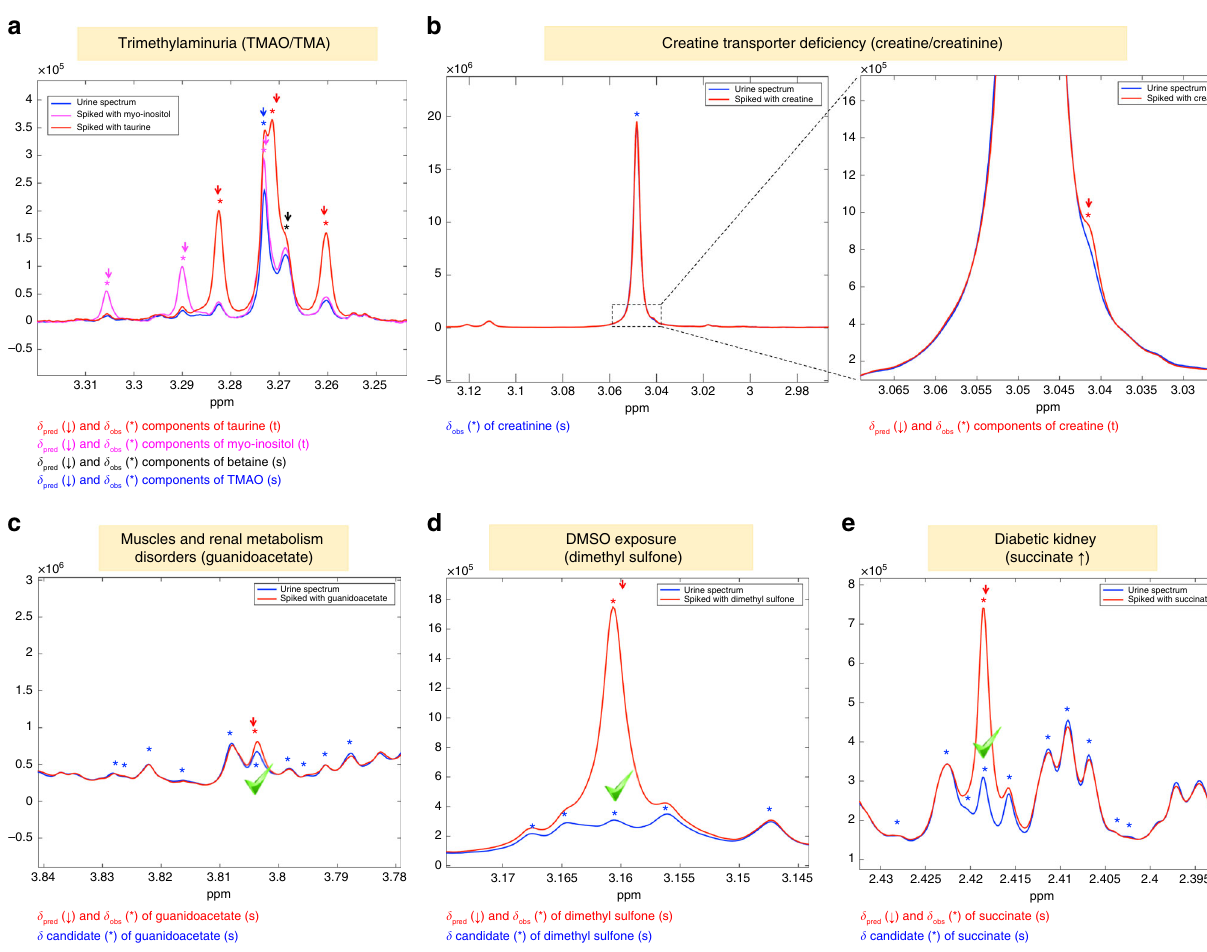
Fig. 7 Examples of dif fi cult metabolite assignments — and therefore quantitation — in urine. a TMAO and TMA are biomarkers of trimethylaminuria; however, accurate determination of TMAO concentration is challenging since many metabolite signals ( δ obs ) are in the same spectral region and should be properly subtracted. To do so, the position of each of them must be known accurately, and it is indeed successfully predicted ( δ pred ) by our predictor, leading to accurate quantitation of TMAO. b The creatine/creatinine concentration ratio is an important clinical parameter, but this ratio is dif fi cult to determine due to the severe overlap between the creatine and creatinine signals. Again, it is shown that the δ value of creatine (although its signal is largely hidden under the strong creatinine peak) is accurately predicted. In crowded spectral areas, several unique signals of metabolites are present, making their assignment very risky. Nevertheless, our predictor always provides accurate chemical shifts predictions as shown for c guanidoacetate, d dimethyl sulfone, and e succinate, in perfect agreement with the observed values, validated by spiking experiments for each